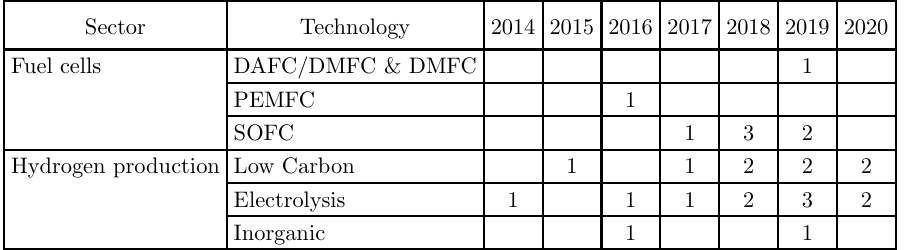
Hydrogen production Low Carbon